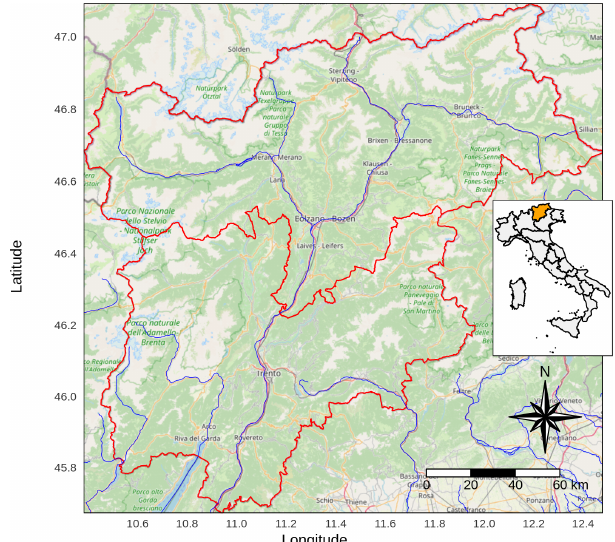
Figure 1. The study region of Trentino-South Tyrol composed of the autonomous provinces of Trento and Bolzano (red bordered) and the region location in Italy (orange area in the inset